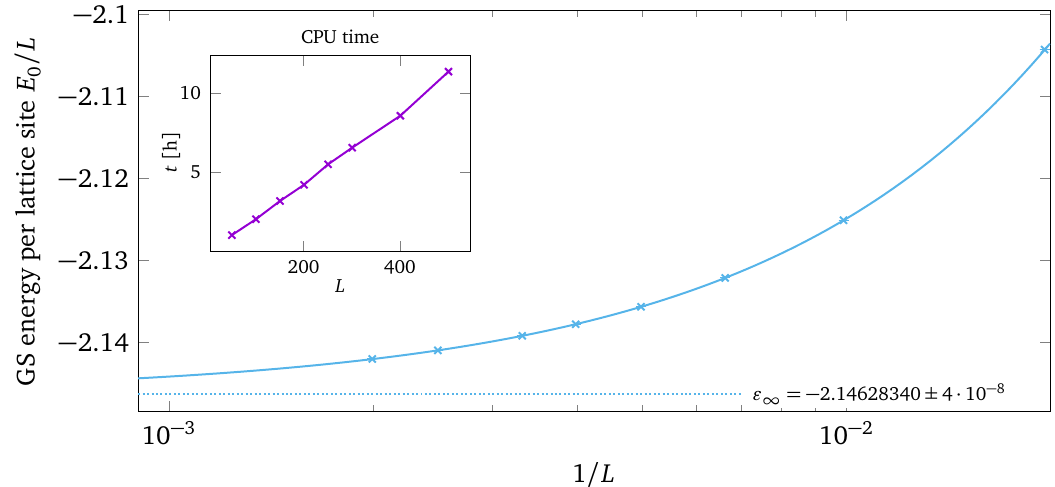
Figure 7: Finite-size scaling for the ground-state energy of the Holstein model at half filling using the projected purification and a two-site DMRG solver. The model is evaluated for parameters ω/ t = 1.0, γ/ t = 2.0 at nearly half filling and a maximum discarded weight per bond δ = 10 − 10 . We chose system sizes L = 51,101,151,201,251,301,401,501 and electron fillings N set shows the total CPU time for the ground-state search as a function of the number of lattice sites L